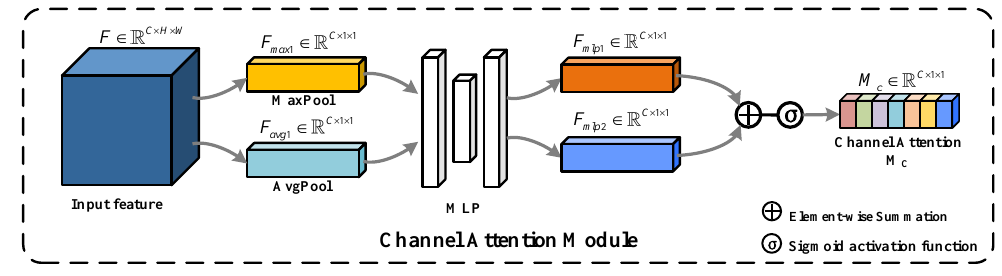
Figure 4. Architecture of